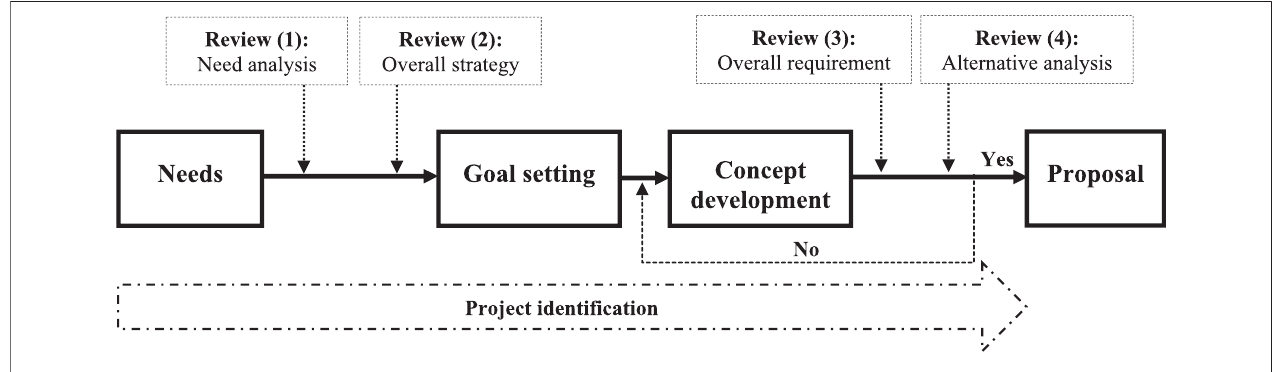
FIGURE 5 | Development process of the project concept.